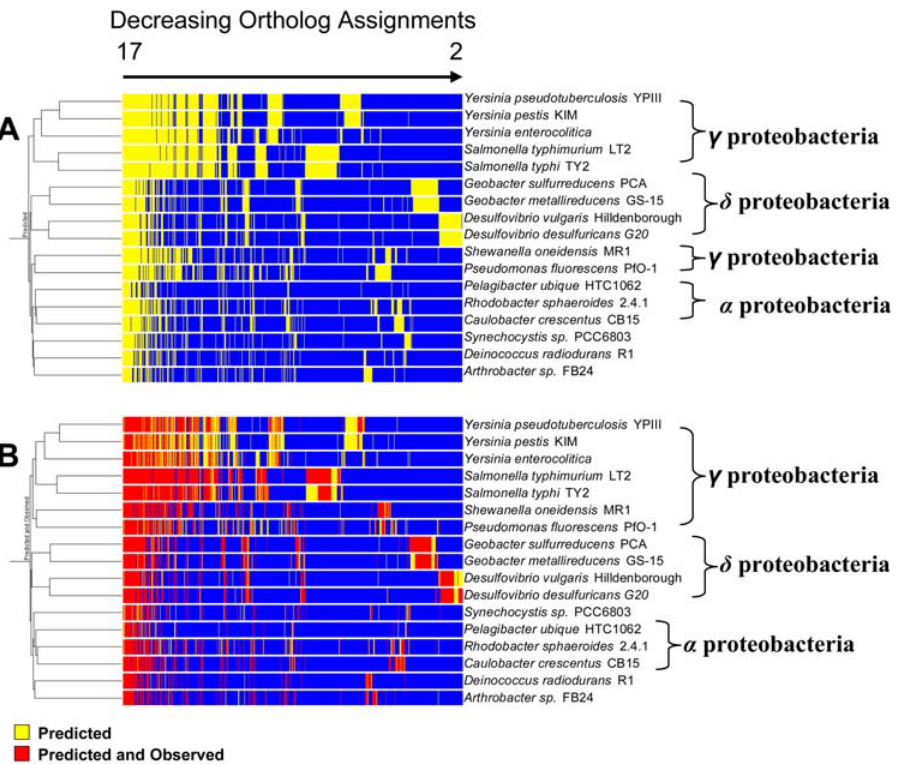
Figure 2. Predicted orthologs verified by proteomic observations. A) Orthologs were predicted between consecutively greater numbers of bacteria, beginning with all pairwise combinations and ending with all of the 17 bacteria. Clustered results reveal a core genome of 144 genes and more exclusive orthologs between bacteria of the same species. B) Observed protein orthologs measured using liquid chromatography tandem mass spectrometry were included and given greater weight than predicted orthologs only. Clustering resulted in improved agreement with phylogenetic predictions. 105 of the 144 core genes were verified by protein observations, which represent the core proteome for the set of bacteria.